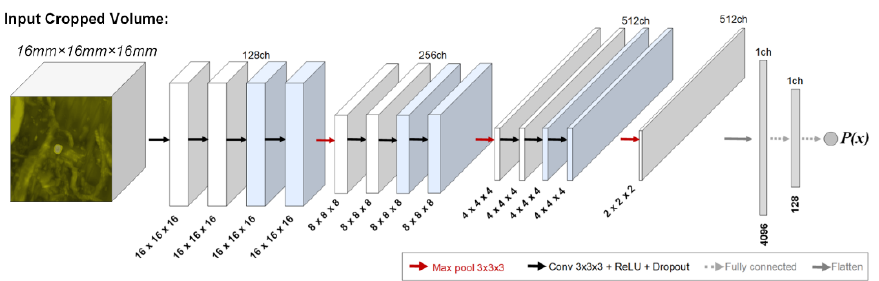
Figure 2. Framework-specific teacher–student models. The network architectures of CropNet-b4-16mm (all blocks) and CropNet-b2-16mm (blocks excluding the blue ones). The input is a 16 mm × 16 mm × 16 mm isotropic region of interest (ROI), where the output is a scalar in the range of [0, 1] giving the probability of input ROI including a BM lesion. The proposed solution utilizes CropNet-b2-16mm (lower-capacity) as the teacher and CropNet-b4-16mm (higher-capacity) as the student models.